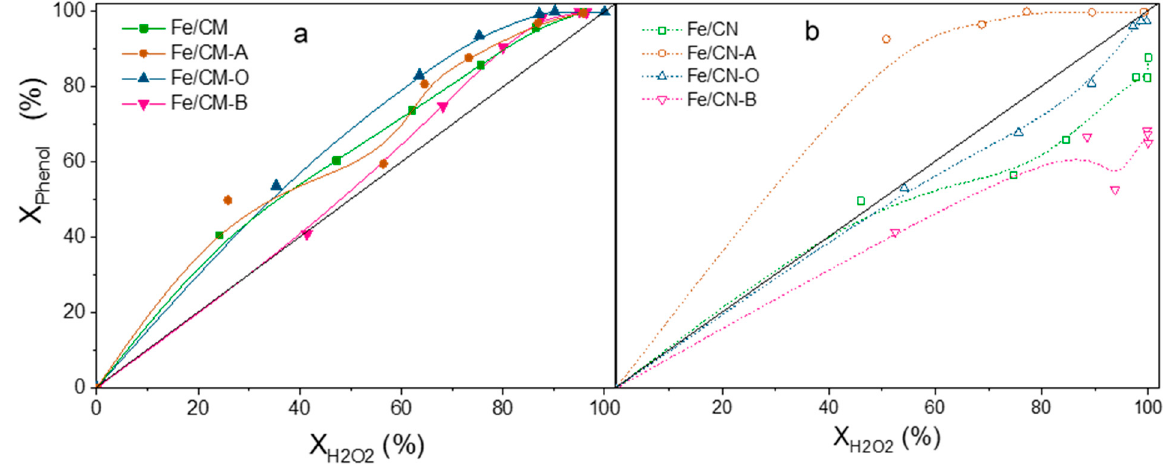
Figure 3. Degradation of phenol with the consumption of H 2 O 2 : ( a ) Fe/CM- f catalysts and ( b ) Fe/CN- f catalysts. Reaction